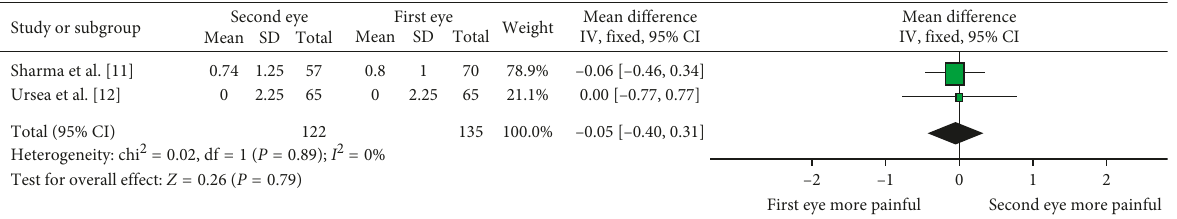
Figure 4: Forest plot comparing the pain scores on the first postoperative day.